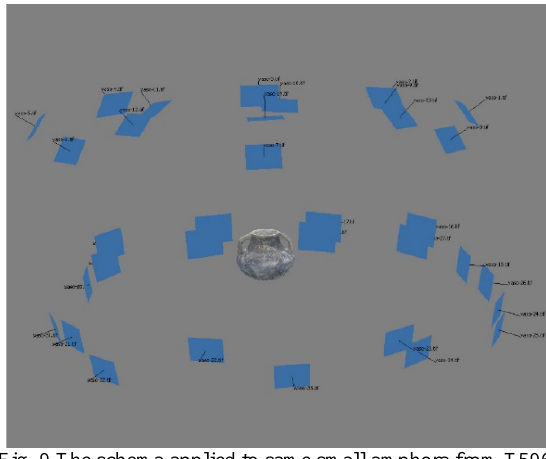
Fig. 9 The schema applied to same small amphora from T596.